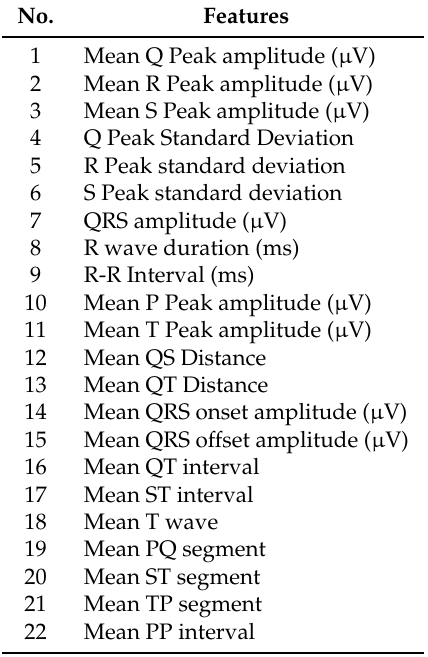
Table 2. Features captured directly from ECG